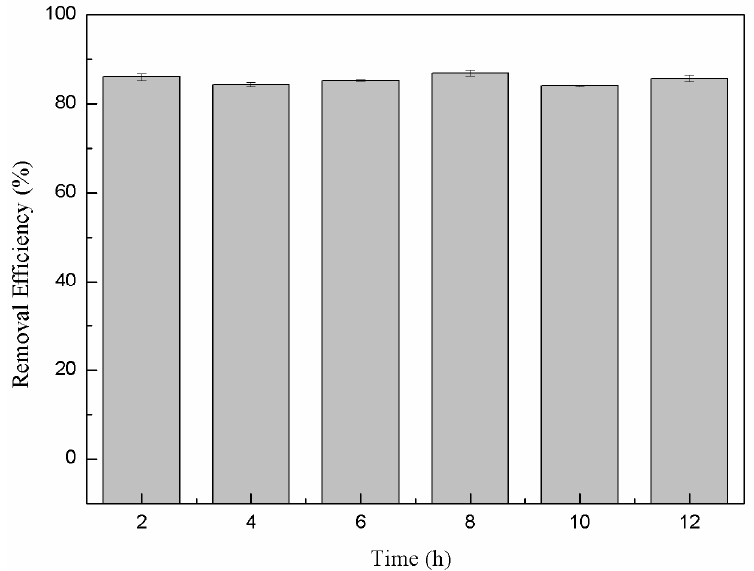
Figure 9. Variation in the removal efficiency of n Fe over time.